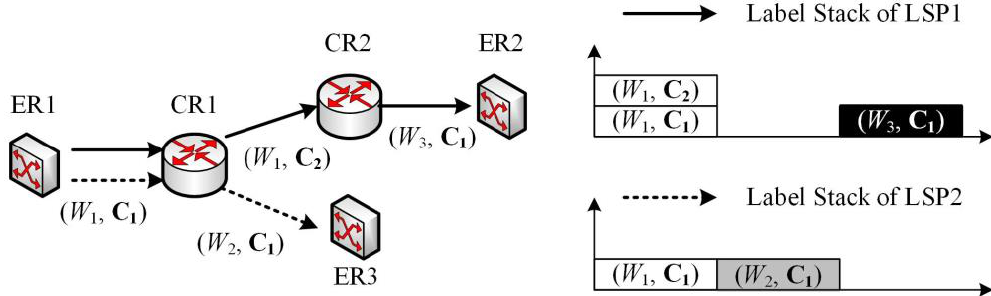
Figure 2. Label stacking in hybrid wavelength and code-switched generalized multi-protocol label switching (GMPLS) network.